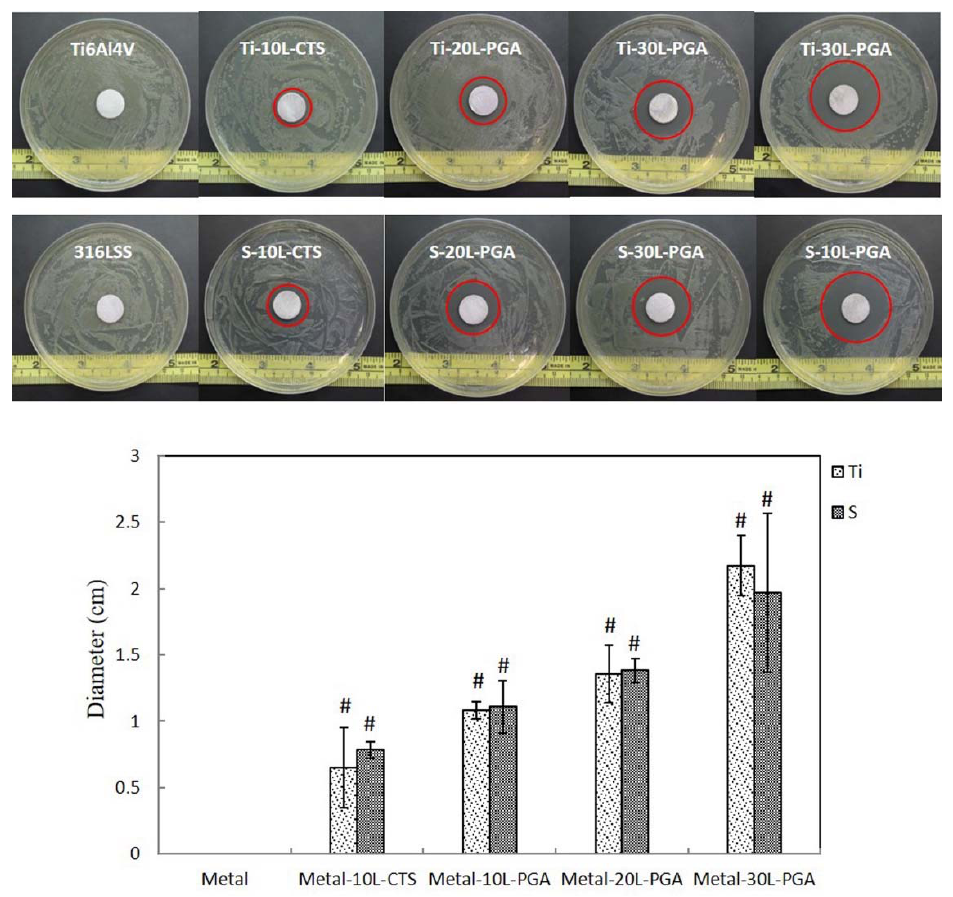
Figure 9. Growth inhibition of E. coli by tetracycline released from Ti6Al4V and 316LSS substrates without and with PEMs coating. The diameter of the zone of inhibition was measured and presented here. #: p < 0.01 compared to bare Ti6Al4V or 316LSS substrate.